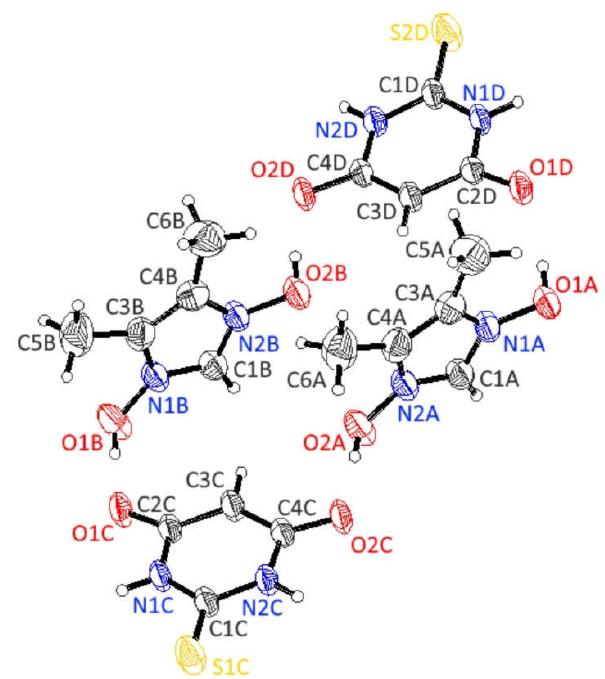
Figure 12. Ortep drawing of the independent unit in TBA/HIMO crystal.